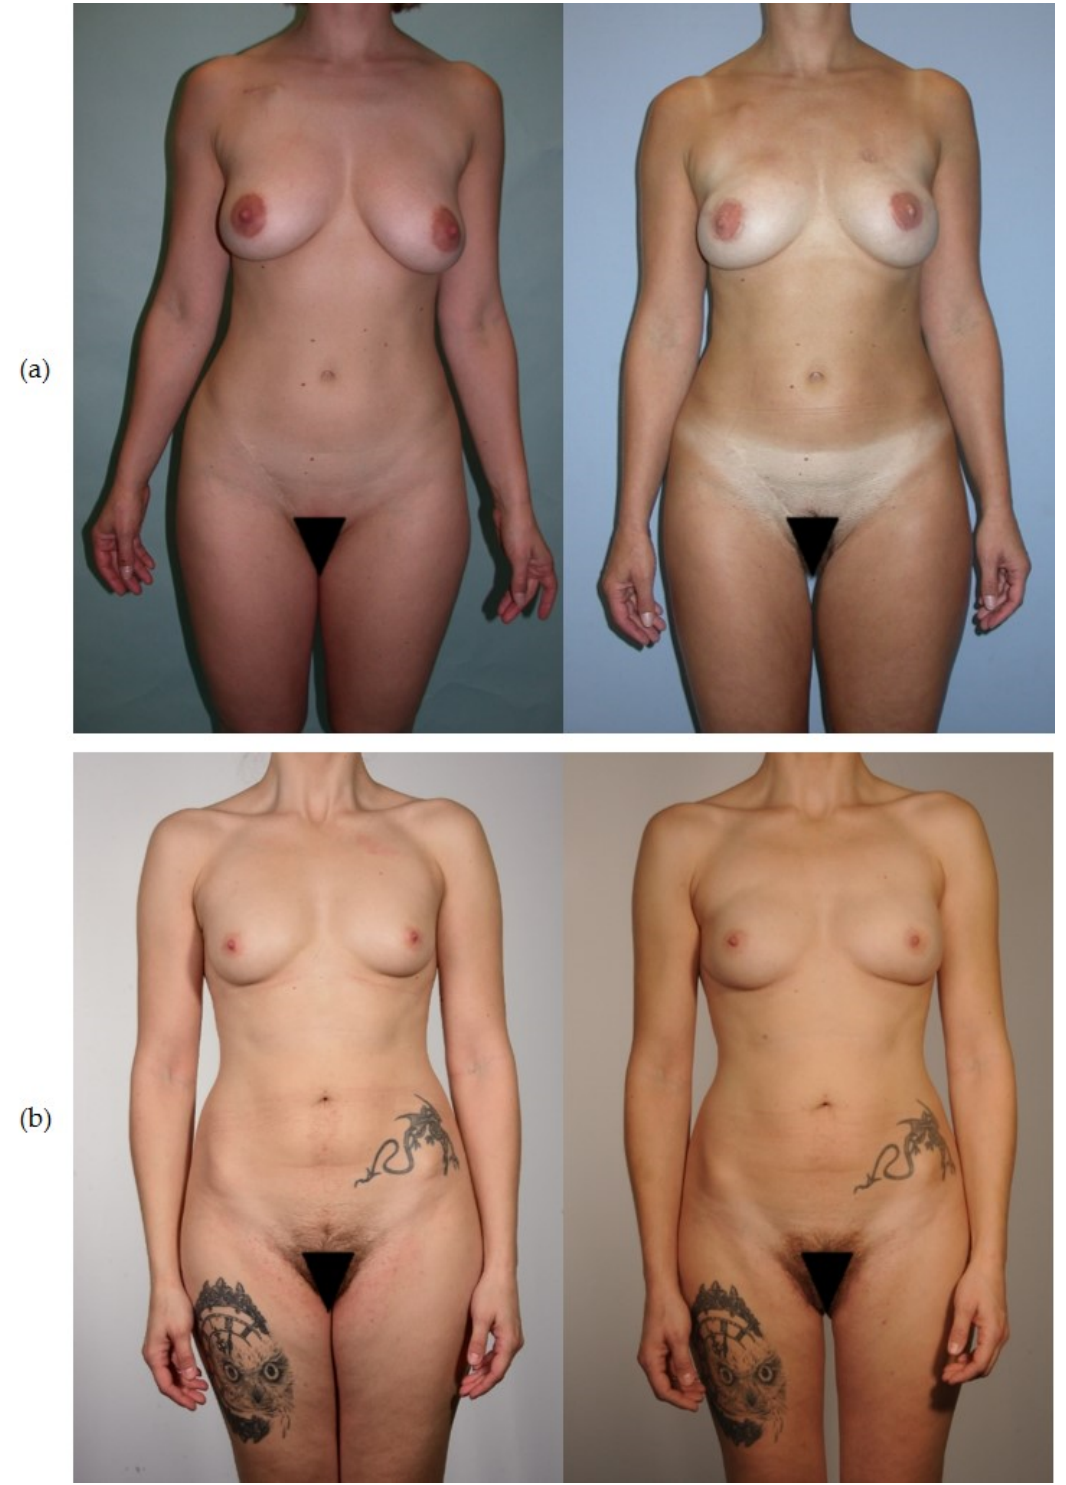
Figure 1. (Left) Preoperative and (right) post-operative views of bilateral breast reconstruction with donor-site in the thigh region: ( a ) TMG flap and ( b ) PAP flap.